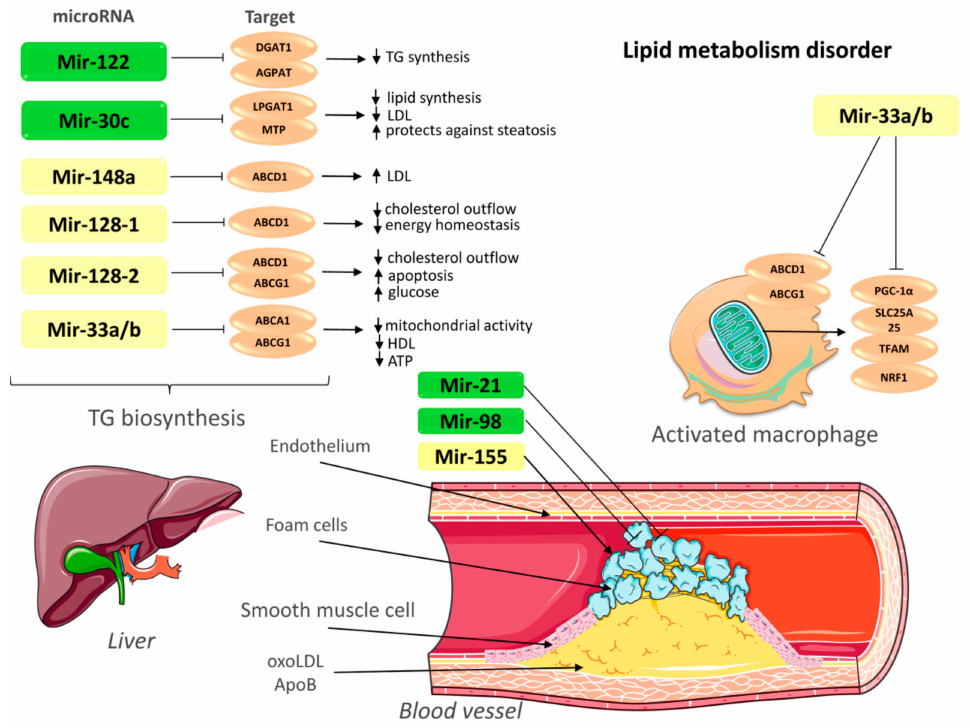
Figure 1. MicroRNAs e ff ect on cellular mechanisms of atherosclerosis. Note: activation → ; suppression ; upregulation ↑ ; downregulation ↓ . TG—triglycerides; LDL—low-density lipoprotein; ABCA1—ATP-binding cassette A1; ABCG1—ATP-binding cassette subfamily G member 1; LPGAT1—lysophosphatidylglycerol acyltransferase-1; MTP—Microsomal triglyceride transfer protein; AGPAT—1-acylglycerol-3-phosphate-O-acyltransferase; DGAT1—Diacylglycerol O-acyltransferase